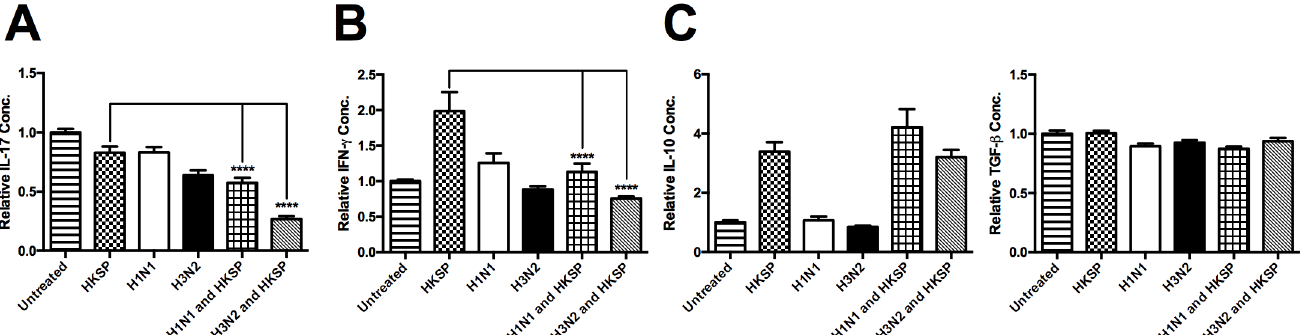
Fig 4. Live IAV attenuates adaptive cytokines in pneumococcus-treated cells. (A) IL-17A, (B) IFN- γ , (C) IL-10, and TGF- β , levels induced in allogeneic CD3 + T cells, co-cultured with CD14 + cells following 24 h treatment with HKSP, live H1N1 or H3N2 alone or in combination with HKSP (or untreated as a control) were determined by ELISA. Each column represents normalised mean cytokine levels + SEM of at least 3 experimental repeats of each treatment/donor. Each ELISA represents normalised results from multiple donors: (A) IL-17A (n = 9), (B) IFN- γ (n = 13), (C) IL-10 and TGF- β (n = 3). Statistical analyses were performed to compare cytokine levels in cells exposed to HKSP versus cells exposed to live H1N1 or H3N2 in combination with HKSP by fitting a One-way ANOVA to the data and using a Sidak test to adjust for multiple testing ( (cid:3) p < 0.05, (cid:3)(cid:3) p < 0.01, (cid:3)(cid:3)(cid:3) p < 0.001, (cid:3)(cid:3)(cid:3)(cid:3) p <